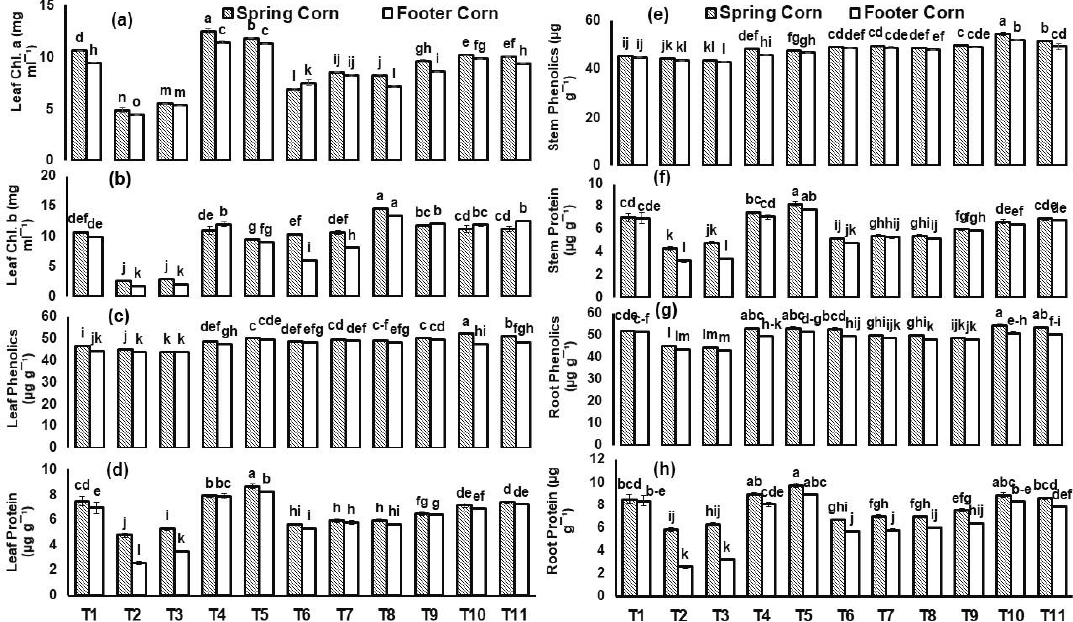
Figure 4. ( a ) Chlorophyll a contents in leaf, ( b ) Chlorophyll b contents in leaf, ( c , d ) Leaf phenolics and proteins, ( e , f ) Stem phenolics and proteins and ( g , h ) Root phenolics and proteins of Zea mays L. plant grown in heavy-metal-contaminated soil under different treatments such as T1 = Control; T2 = Cu(300 ppm); T3 = Ni(100 ppm); T4 = F2; T5 = BC(2%); T6 = F2 + Cu(300 ppm); T7= F2 + Ni(100 ppm); T8 = BC(2%) + Cu(300 ppm); T9 = BC(2%) + Ni(100 ppm); T10 = F2+ BC(2%) + Cu(300 ppm) and T11= F2+ BC(2%) + Ni(100 ppm). Values are the average of three replicates ± standard error (SE). Mean bars sharing similar lower-case alphabetic letters were non-significant ( p < 0.05) to each other, while different letters represented significant difference declared by one-way ANOVA using LSD test at p ≤ 0.05.